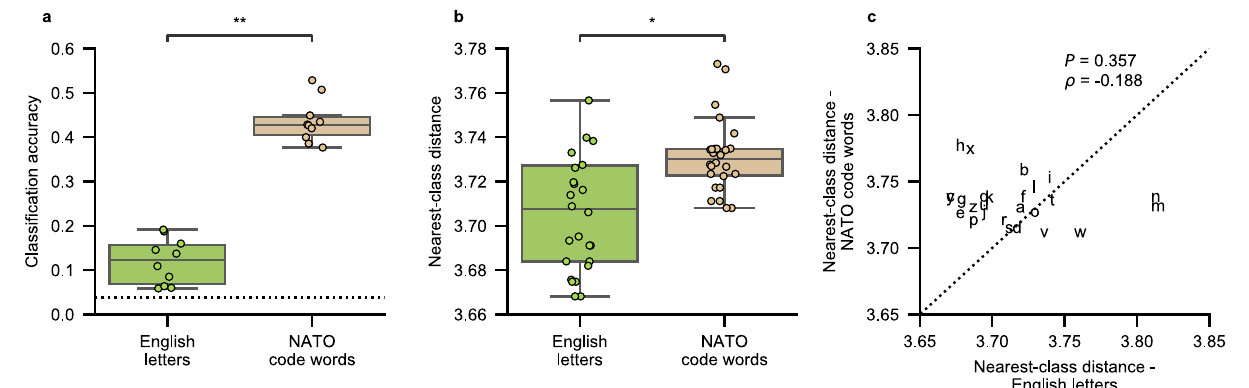
Fig. 4 | Comparison of neural signals during attempts to silently say English letters and NATO code words. a Classi fi cation accuracy (across n =10 cross- validationfolds)usingmodelstrainedwithHGA+LFSfeaturesissigni fi cantlyhigher for NATO code words than for English letters (** P =1.57×10 − 4 , z =3.78, two-sided Wilcoxon Rank-Sum test). The dotted horizontal line represents chance accuracy. b Nearest-classdistanceissigni fi cantlylargerforNATOcodewordsthanforletters (boxplots show values across the n = 26 code words or letters; * P =2.85×10 − 3 , z =2.98,two-sided Wilcoxon Rank-Sum test).In a , b , eachdata point is plotted asa